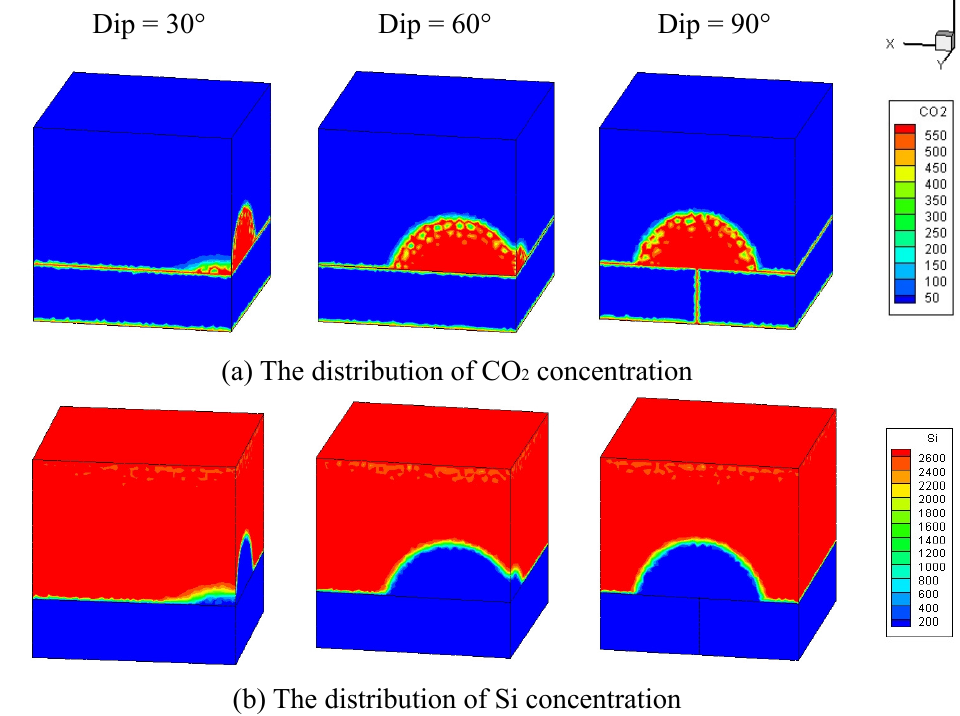
Figure 8. Numerical results of CO 2 leakage and grout reactive concentration for 365 days with different dip of